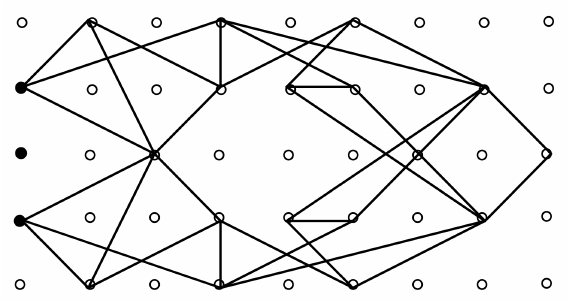
Figure 17. Optimization results in this paper.